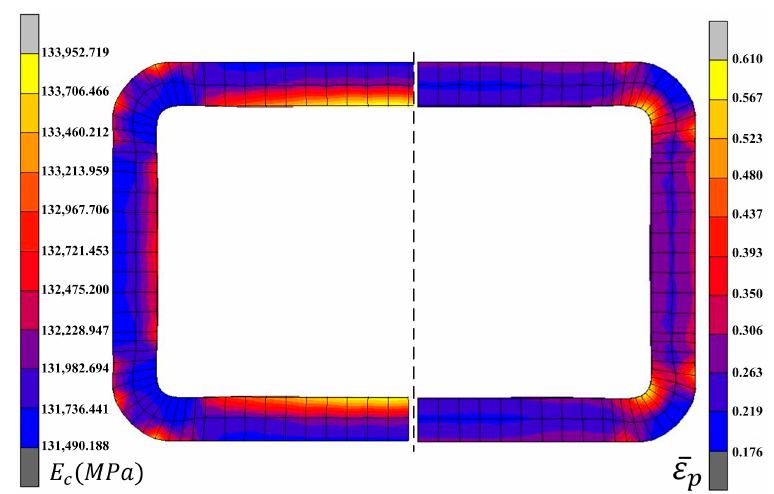
Figure 8. Simulation results of the chord modulus in roll forming.